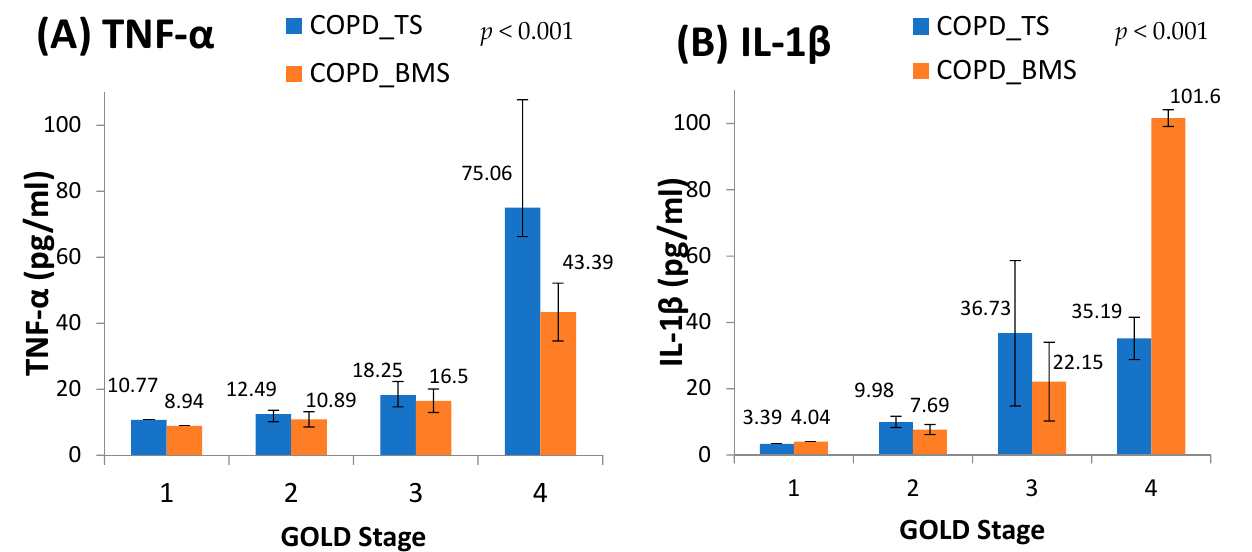
Figure 4. Dose response relationship between ( A ) TNF- α (pg/mL), ( B ) IL-1 β (pg/mL), and GOLD staging among smoking COPD and biomass COPD cases. The p values for the difference between the mean levels of TNF-a among the TS-COPD and BMS-COPD were 0.32 for Stage 1, 0.017 for Stage 2, 0.176 for Stage 3, and 0.202 for Stage 4. The p values for the difference between the mean levels of IL-1 β among the TS-COPD and BMS-COPD were 0.32 for Stage 1, 0.0003 for Stage 2, 0.016 for Stage 3, and 0.0455 for Stage 4.